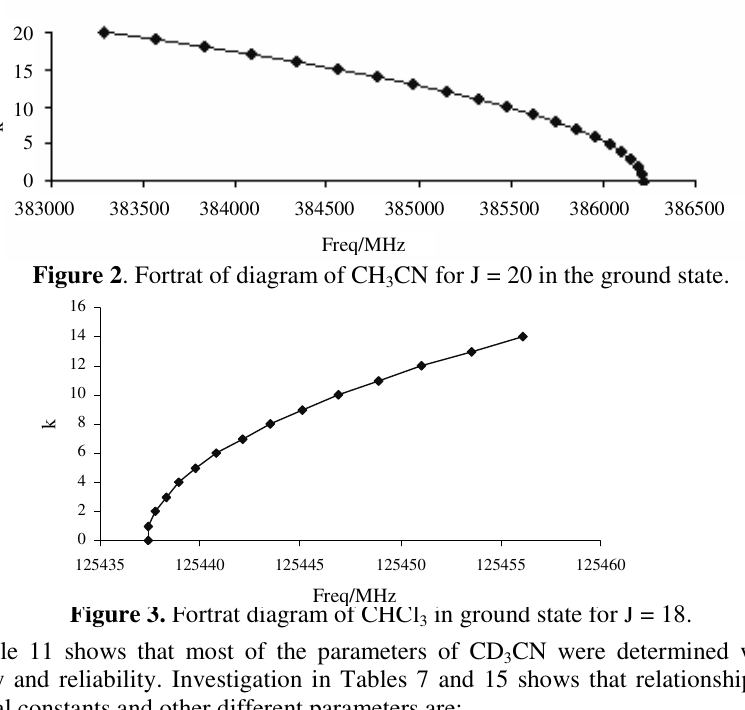
Figure 3. Fortrat diagram of CHCl